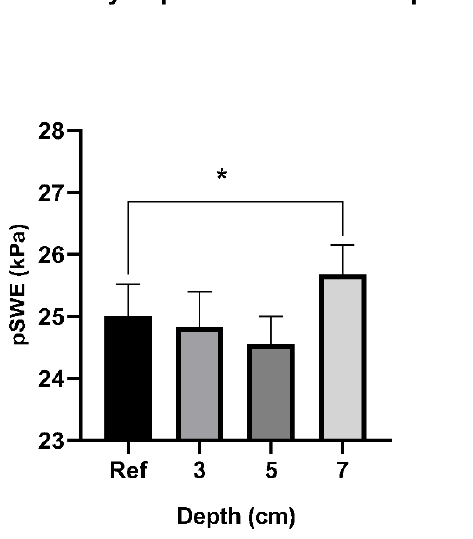
Figure 4. Accuracy of pSWE measurements at different depths compared to manufactrure reference value. There is a significant different between pSWE measurements at depths of seven cm compared to reference value ( p = 0.024). No significant differences in pSWE at depths of three cm or five cm when compared to reference value. Mean, SEM (* p < 0.05 using one-sample t -test between pSWE measurements at different depths and reference value, number of pSWE measurements per depth = 60).